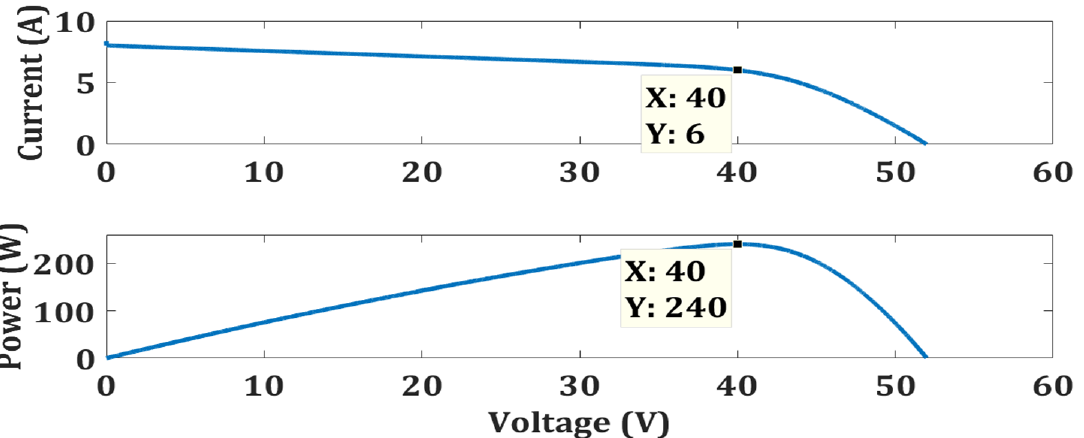
Figure 13. Characteristic curves of 4S2P PV system for test case 1 .